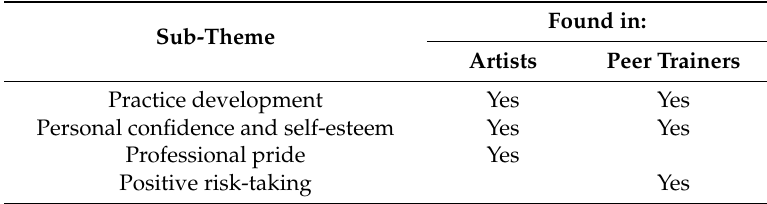
Table 5. Sub-themes of the theme ‘Development as trainers’.